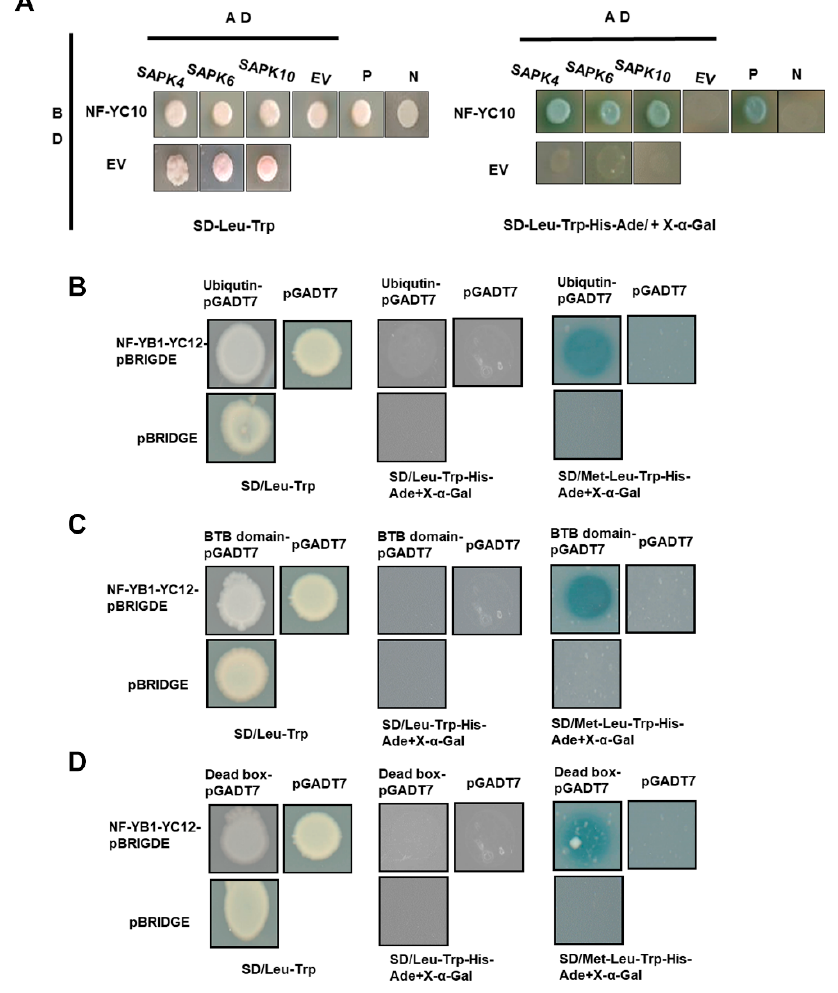
Figure 5. ( A ) Y2H assay of interaction between NF-YC10 and SAPKs. BD: pDEST32; AD: pDEST22; EV: empty vector, pDEST32 or pDEST22; P: positive control, pGBKT7-53/pGADT7-T; N: positive